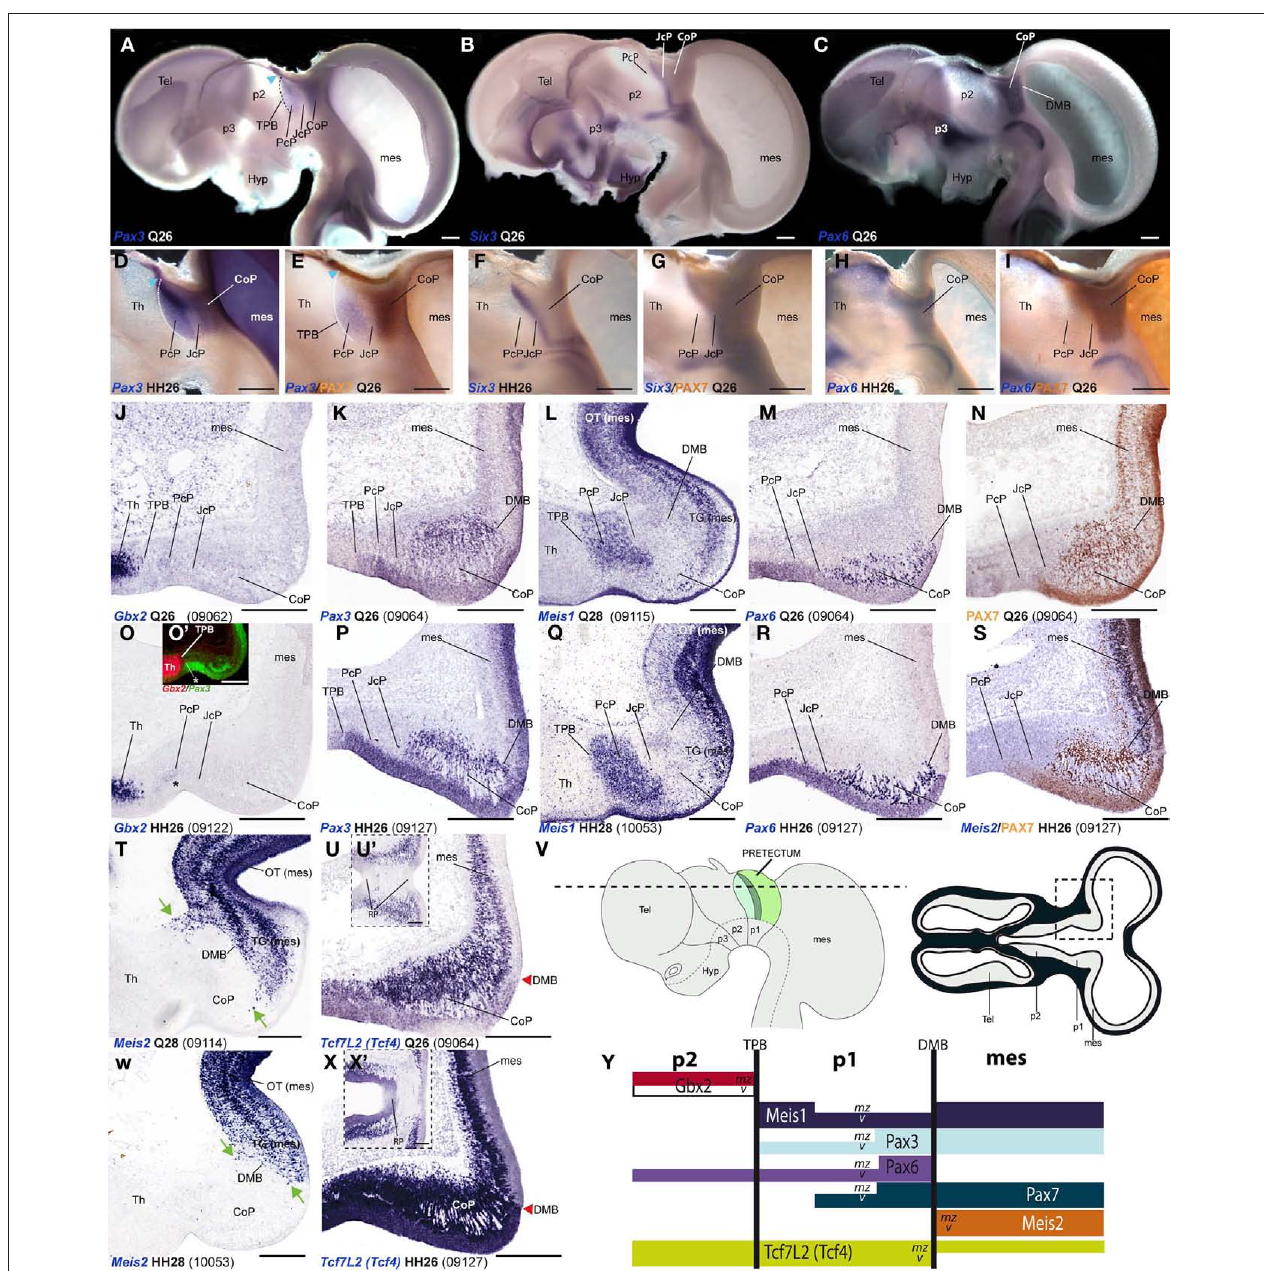
from the same specimen may appear in different panels or plates). Inset (O ′ ) compares in pseudocolor the patterns of Gbx2 and Pax3 , demonstrating that the cell group marked with an asterisk (O,O ′ ) lies caudal to the thalamo- pretectal boundary. Insets (u ′ ,X ′ ) show horizontal sections passing through the roof of the pretectum, where Tcf7l2 is not expressed. Green arrows in (T,W) : Meis2 positive cells at the CoP. The schemata in (V) represent a lateral view of the brain indicating the horizontal section plane used, and the position in such sections of the pretectal region that appears magnified in the panels (dashed box). (Y) Schema of gene combinations mapped in the midbrain (mes) and diencephalic prosomeres p1 and p2. Each gene is represented by a color-coded bar. The upper and lower halves of each bar represent gene expression in the mantle (mz) or ventricular zones (v) respectively. Scale bars =